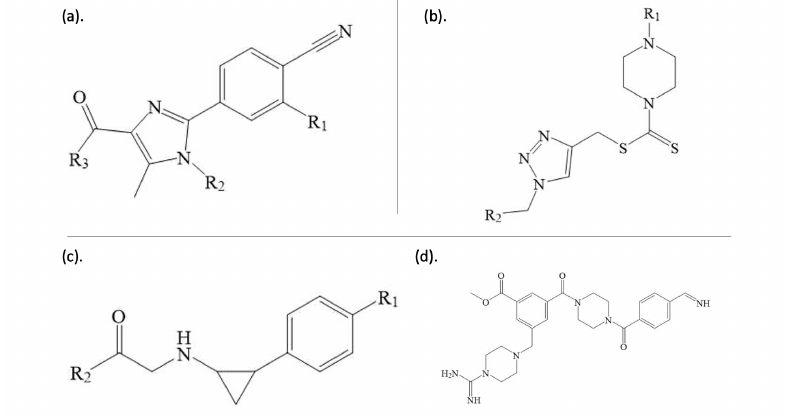
Figure 3. Core structures of molecules in Clusters A, B, and C from the t-SNE analysis, shown in ( a – c ), respectively. R 1 in ( c ) is shown in the para position, but there are also compounds in this cluster with R 1 in the meta position. ( d ) shows the full structure of one unusual molecule from Cluster C, which in fact does not have the core structure shown in ( c